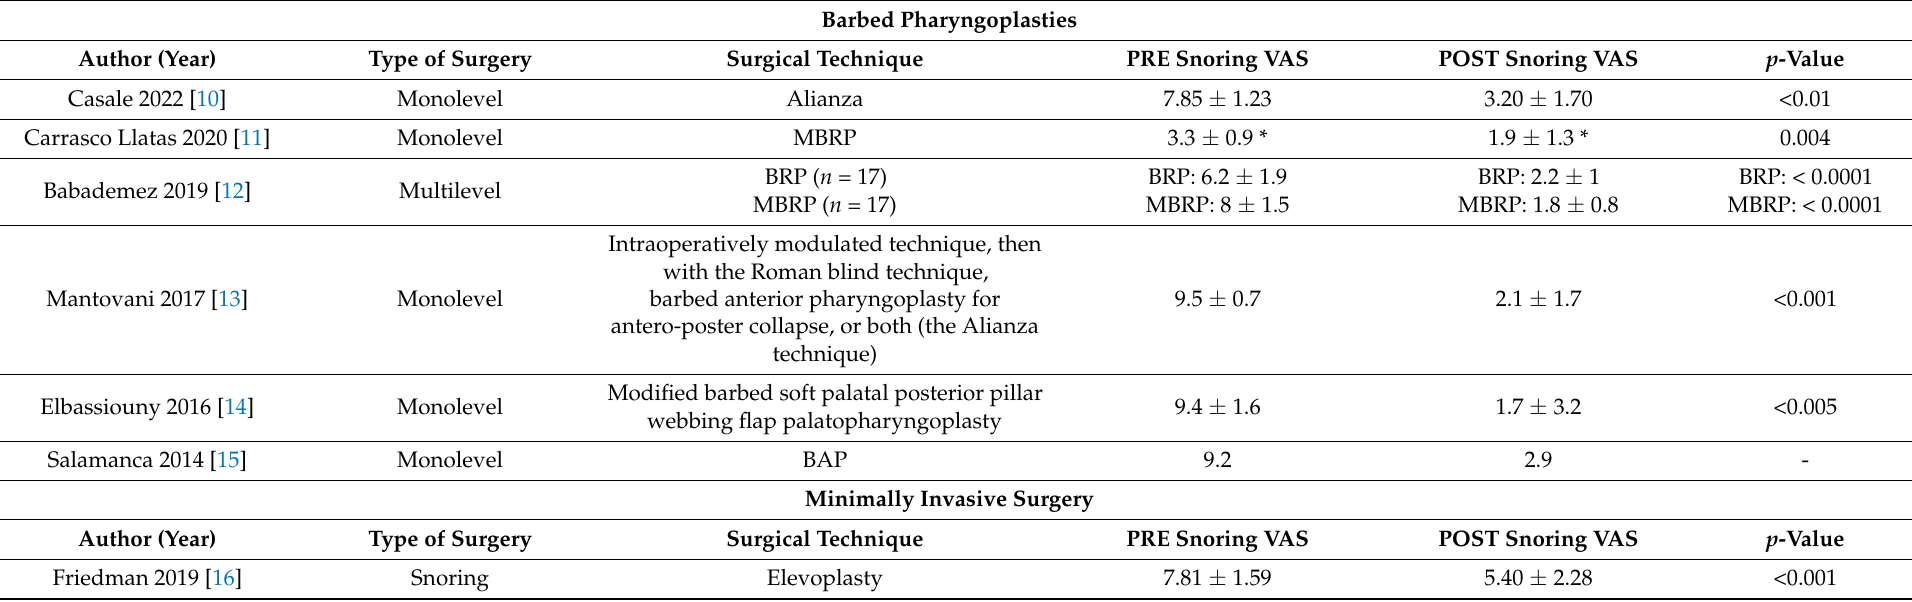
Table 2. Summary of studies specifically involving the use of BS for the treatment of